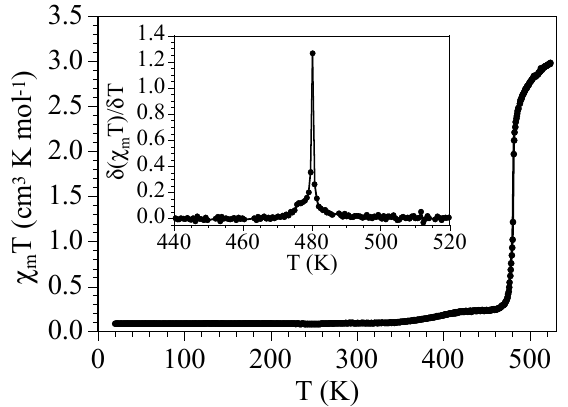
Figure 3. Thermal variation of the χ m T product for complex 1 . Inset shows the thermal variation of the derivative of χ m T as a function of temperature.